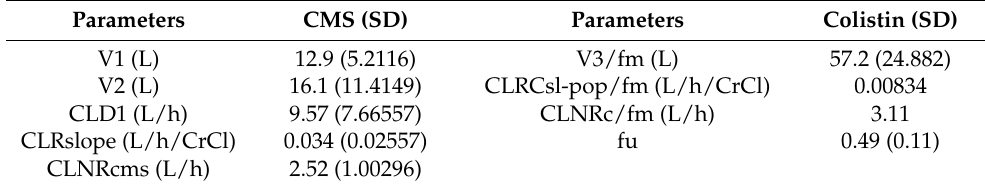
Table 1. The population pharmacokinetic (PK) parameters of colistin in critically ill patients.